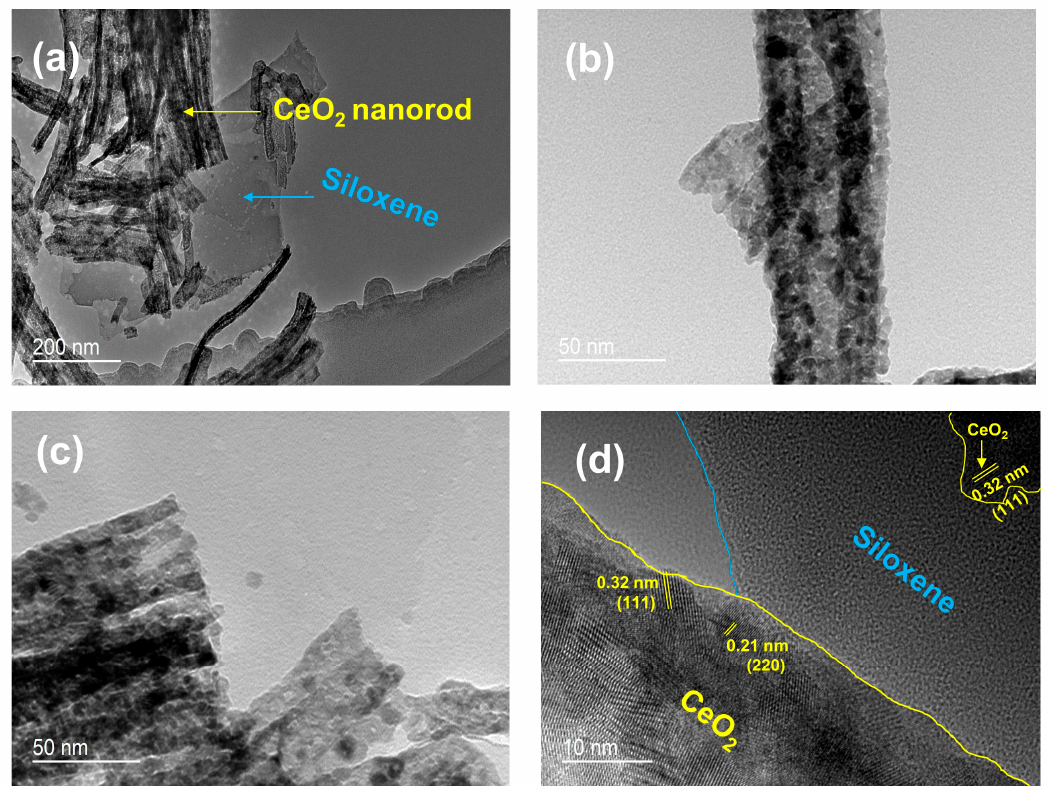
Figure 4. ( a – c ) Transmission electron microscopy (TEM) and ( d ) High-resolution transmission electron microscopy (HRTEM) images of the CeO 2 /siloxene composite.